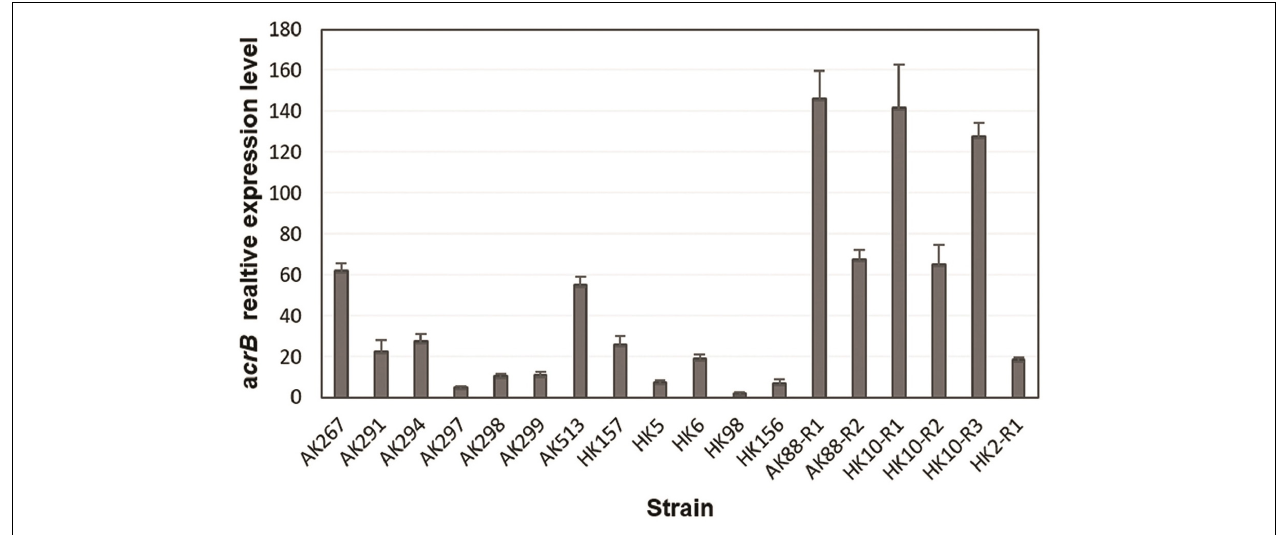
FIGURE 1 | Relative expression of acrB gene from tigecycline (TGC)-non-susceptible isolates of Klebsiella pneumoniae from different origins determined by